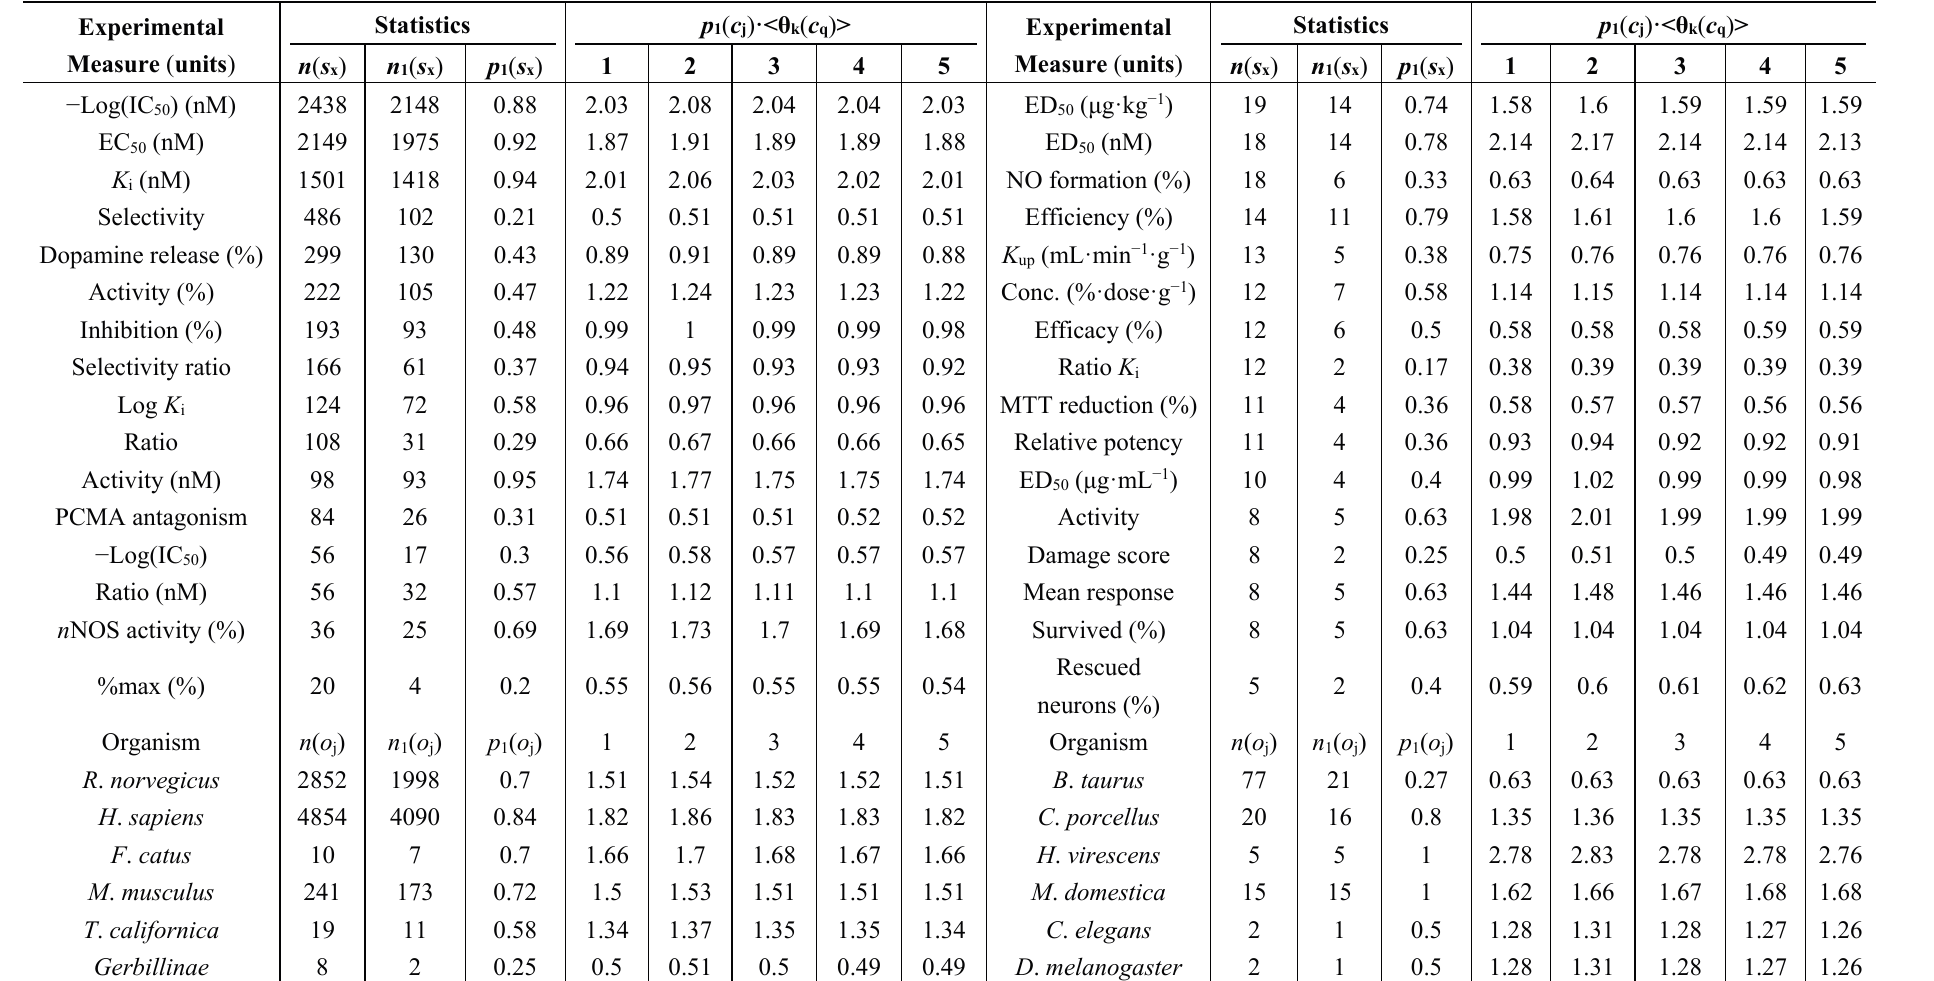
Table 3. Examples of multi-scale, multi-target, or multi-output MA values for different targets, measures, and organisms.